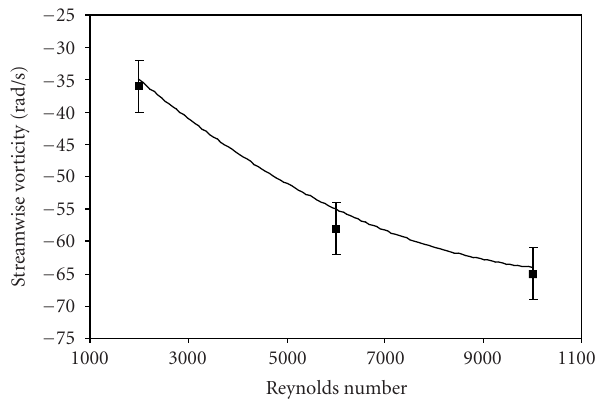
Figure 2: Streamwise vorticity as a function of Reynolds number.